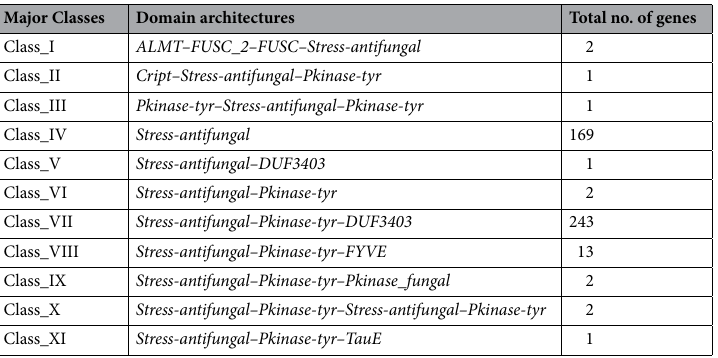
Table 1. Major classes of cotton CRKs. The classification is based on absence and presence of additional functional